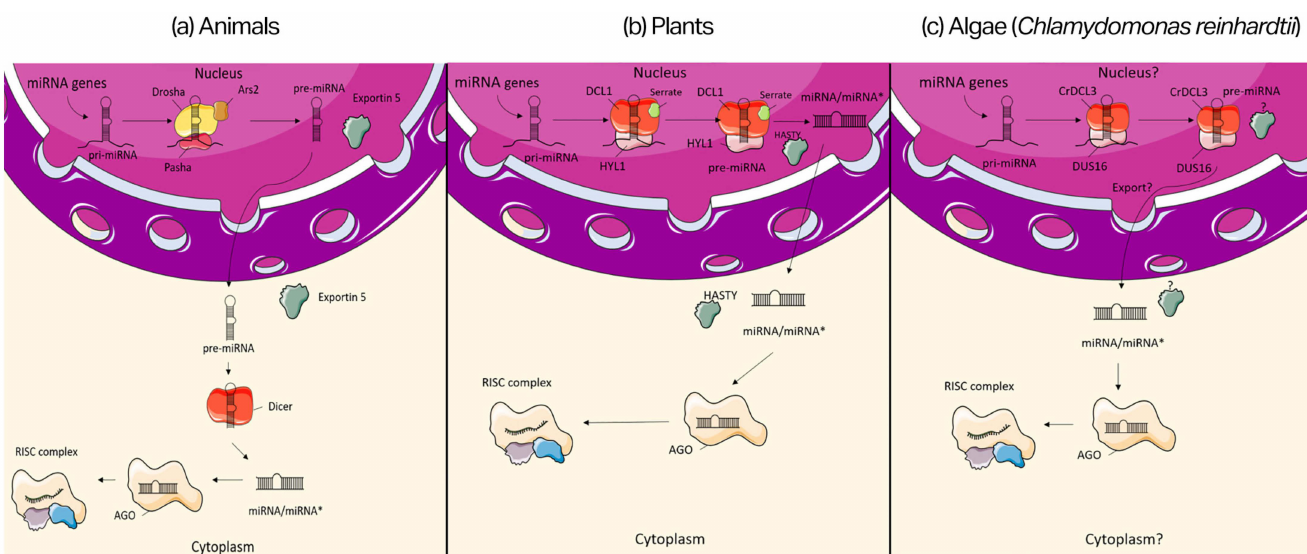
Figure 1. Schematic representation of miRNA biogenesis in animals, plants, and algae. For algae, the example of Chlamydomonas reinhardtii has been taken into consideration, for which greater information is available on miRNA processes with respect to other algae. Elements that have the same color exert similar actions in the process, whereas the “?” symbol indicates unknown processes or factors, and the “*” symbol shows the miRNA strand that will be not maintained on the AGO protein, but later released and degraded. ( a ) In animals, miRNA genes code for miRNA precursor (pri-miRNA) that is processed in the nucleus by an RNAse III enzyme Drosha, and by the co-factors Pasha and Ars2. The processing of pri-miRNA forms another precursor (pre-miRNA) that is exported by Exportin 5 in the cytoplasm, where it is again processed by another RNAse III enzyme Dicer. The Dicer activity forms a duplex of miRNA/miRNA* that is loaded onto an Argonaute (AGO) protein. ( b ) In plants, the pri-miRNA is processed by the RNAse III enzyme Dicer-like 1 (DCL1), a homologue of Dicer, with the help of HYL1 and SERRATE. DCL1 processes both the pri-miRNA and pre-miRNA precursors forming a duplex of miRNA/miRNA* in the nucleus, which is exported in the cytoplasm by the HASTY protein. Here, it is loaded onto an AGO protein. ( c ) In Chlamydomonas reinhardtii , both the pri-miRNA and pre-miRNA are processed by the RNAse III enzyme CrDCL3, with the help of DUS16. This forms the duplex of miRNA/miRNA* that is loaded onto an AGO protein. In all species, animals, plants, and algae, the AGO protein shows affinity for only one of the two strands of the duplex miRNA/miRNA*, that will be retained and will constitute the core component of the RISC